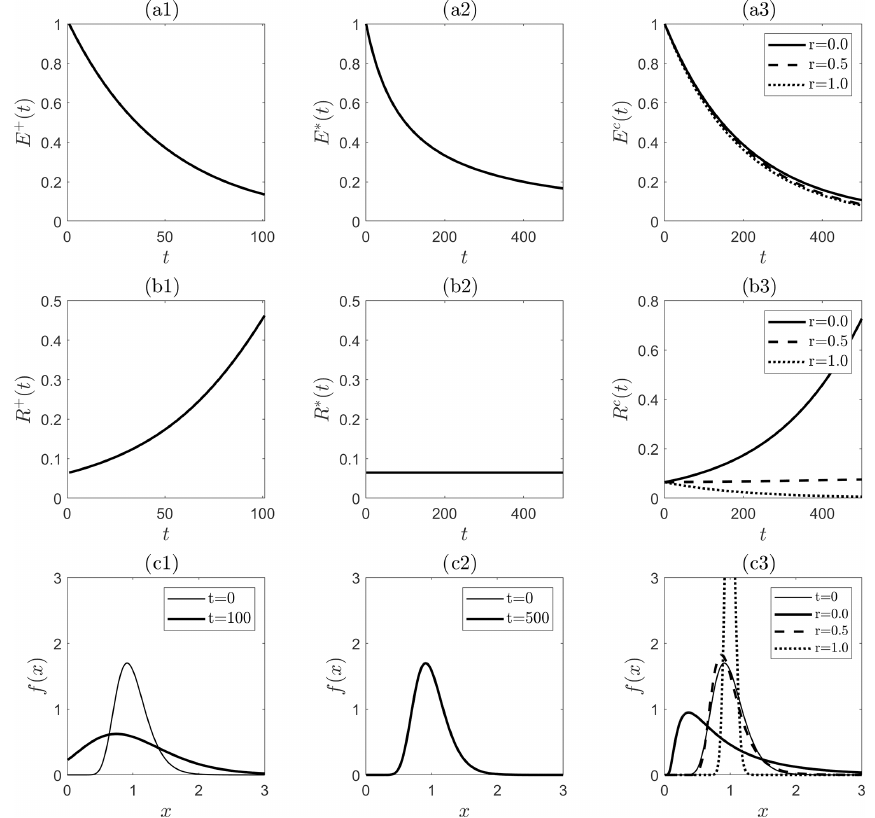
Figure 3. Evolution of an initial ( t = 0) lognormal probability density function under the Fokker–Planck equation generated by various ker- nels. Summation kernel: (a1) – (c1) . Product kernel: (a2) – (c2) . Compound kernel: (a3) – (c3) . First row (a1–a3) : mean E ( t ). Second row (b1– b3) : relative variance R ( t ). Third row (c1–c3) : initial ( t = 0) and final densities f ( x,t